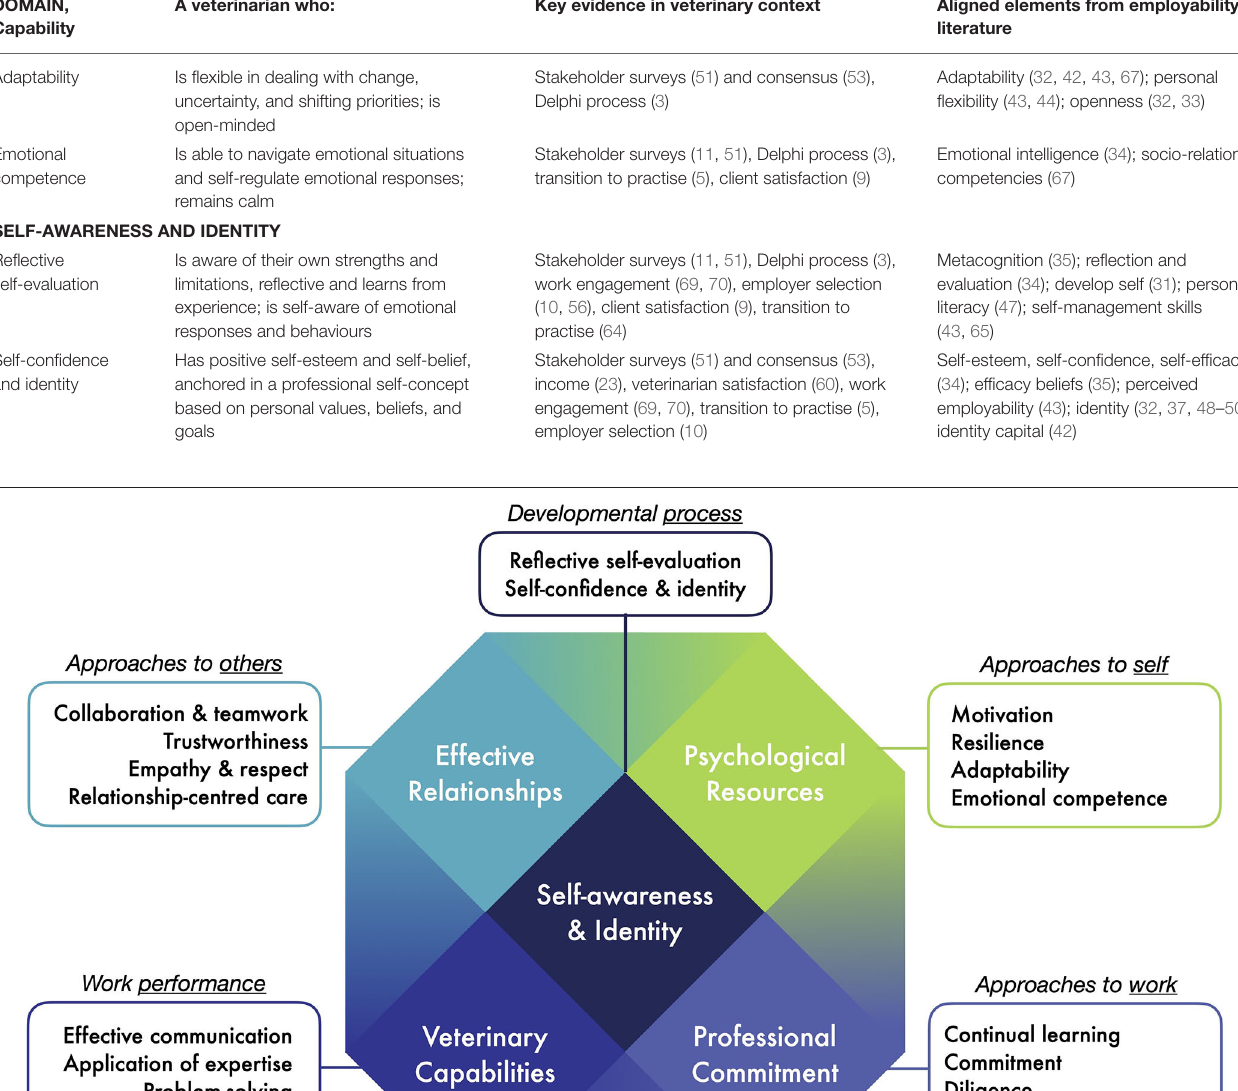
automatically. Over-full and content-heavy curricula may leave employability easily crowded out by more traditional disciplinary outcomes (74). Faculty may resist giving up curriculum space to content they view as “soft,” or may lack the capacity to confidently teach it (48). Another potential pitfall is mismatch with the hidden curriculum, if staff role models do not “walk the